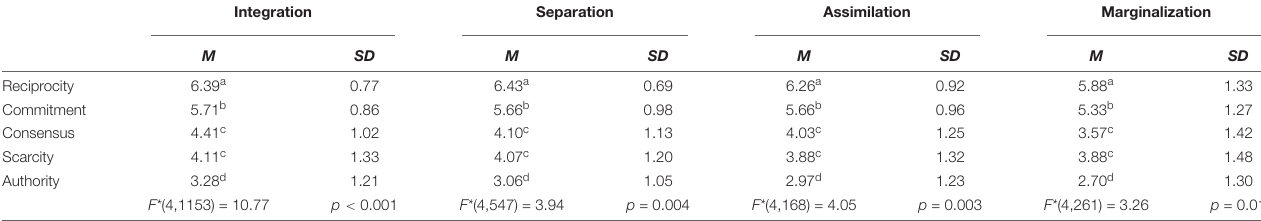
TABLE 6 | Post hoc RM-ANCOVAs and Bonferroni adjusted pairwise comparisons between the persuasion strategies based on the acculturation modes. Integration Separation Assimilation Marginalization M SD M